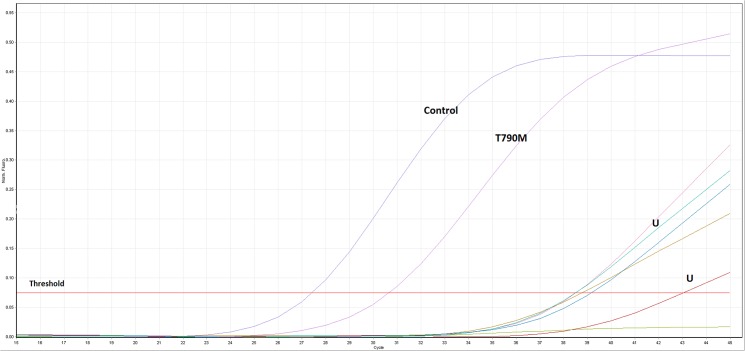
Real-time PCR analysis.Real-time PCR analysis of the EGFR-T790M point mutation. The figure shows a representative sample showing the T790M point mutation detected in a patient sample: the control-curve indicates the amplification of a region of exon 2 of the EGFR gene and is used to assess the total DNA in the sample while the T790M-curve indicates the amplification of the T790M-mutant allele in the sample. The other curves labelled with U indicate unspecific amplification of DNA (not present in further analysis).